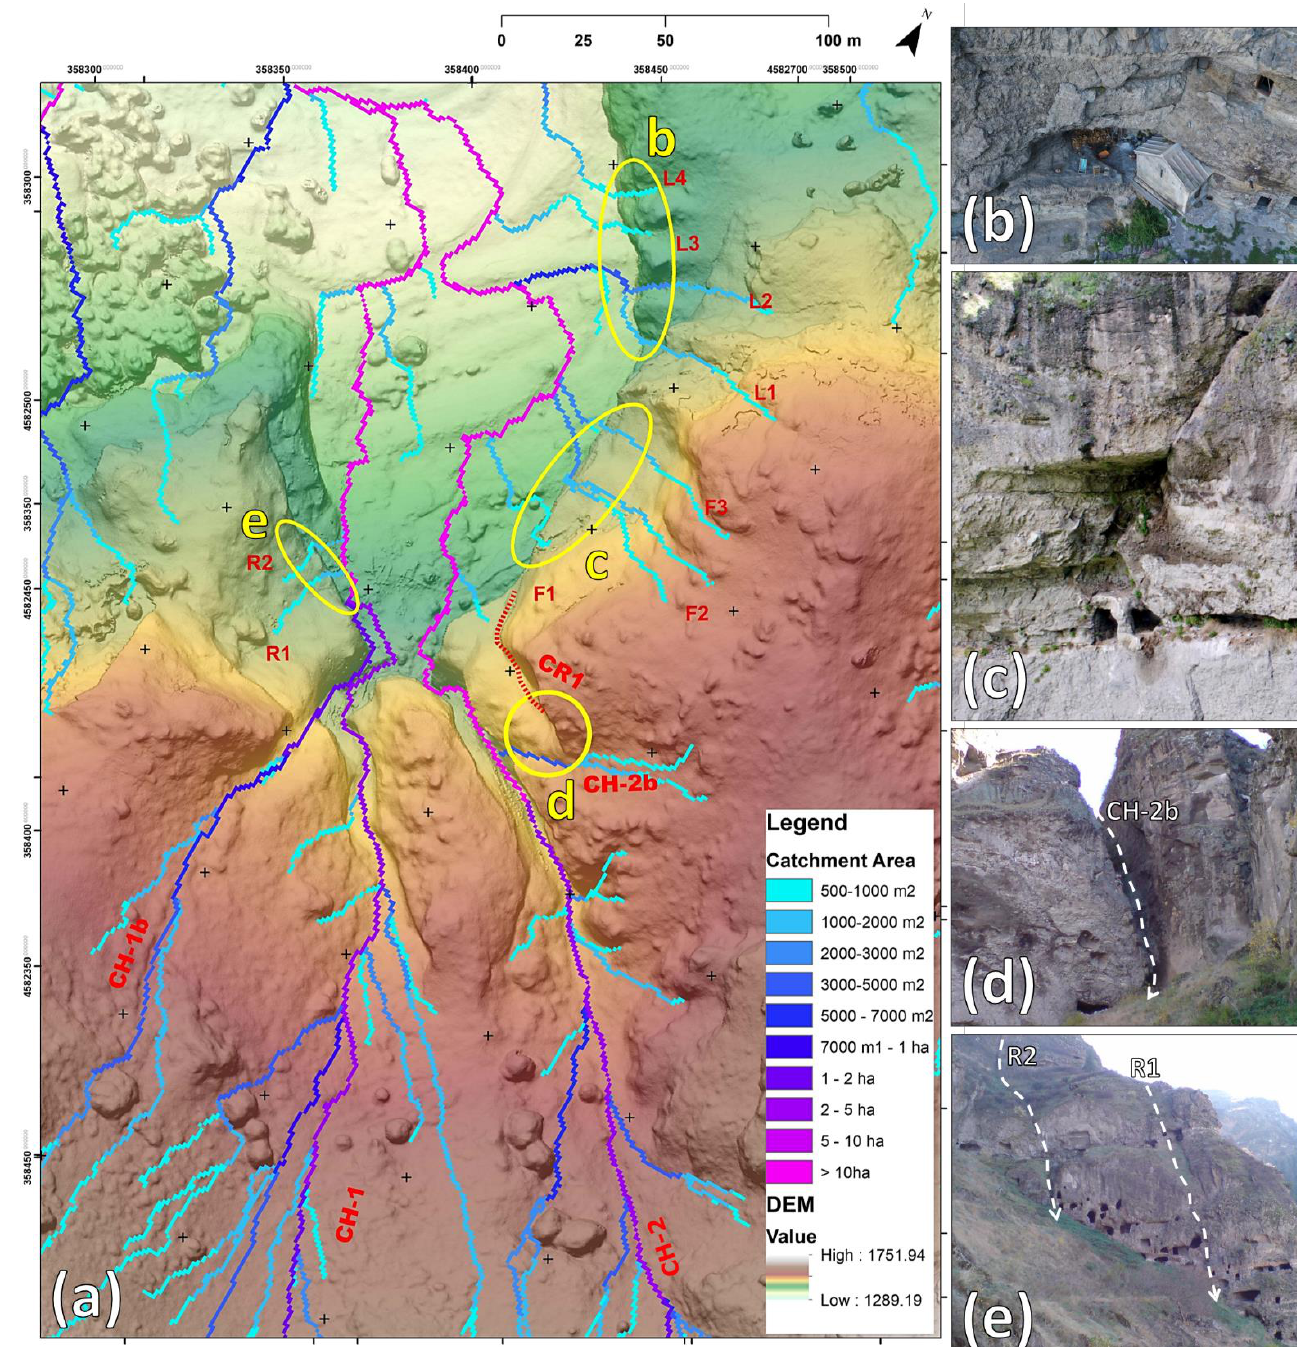
Figure 7. Vanis Kvabebi surface water run off model: ( a ) 14 cm resolution DSM with streams categorized by catchment area (ovals highlight details in b-e; stream legend: L = left cliff; F = front cliff; R = right cliff; CH = channels); ( b ) top-view of the lower chapel area; ( c ) Large niche created by erosional features of the J2 set Master Joint; ( d ) erosional channel in correspondence of J3 fracture; ( e ) stream gullies on the slope of the ravine opposite the monastery.